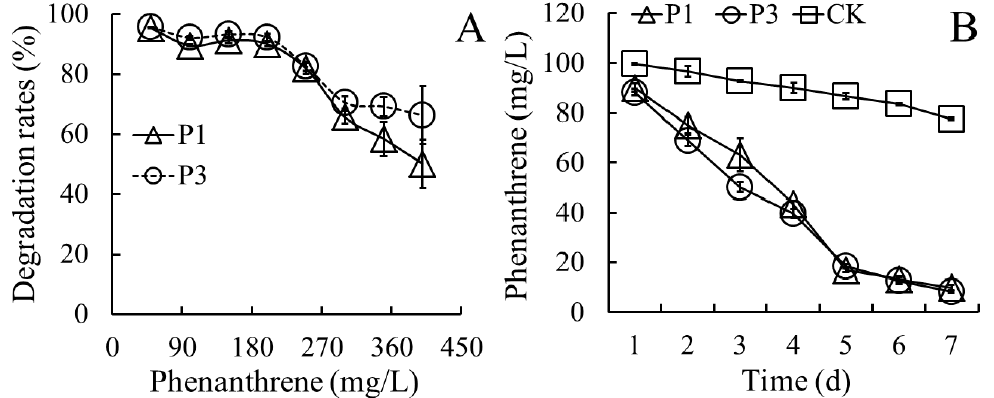
Figure 3. Degradation of different concentrations of PHE by the two bacterial strains ( A ) and the degradation of 100 mg/L PHE at different incubation times ( B ).